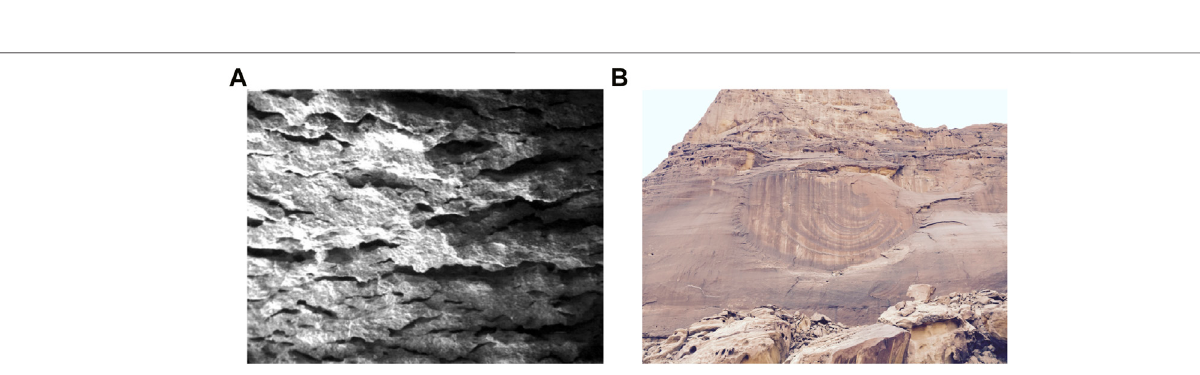
Frontiers in Mechanical Engineering |